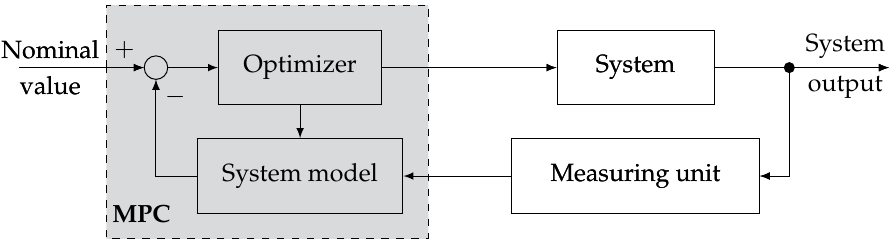
Figure 2. Closed-loop control system with an MPC controller, including an optimizer and a pro- cess